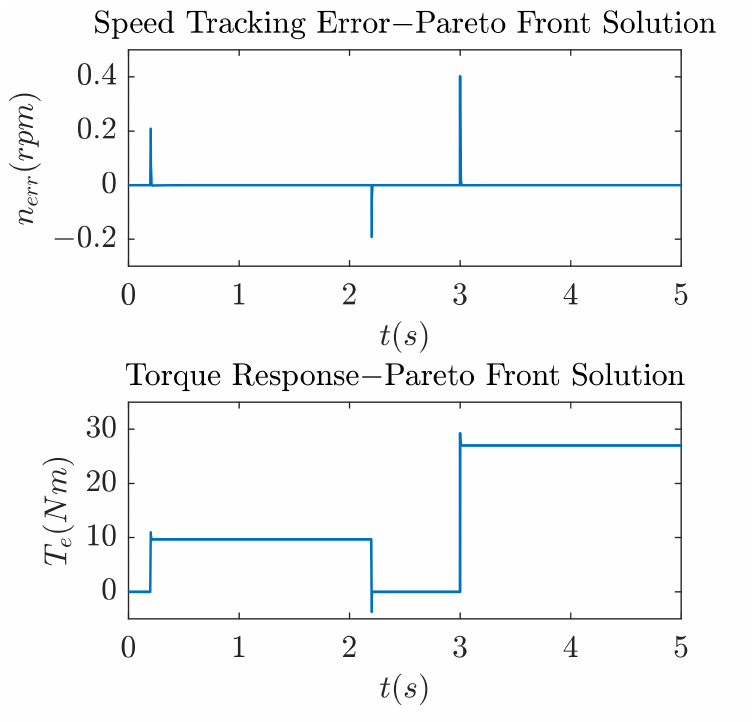
Figure 9. System response using the solution of the Pareto front. Figure 10 represents the speed and torque responses of the criteria from Equation (26) with the weighing factor of value 10. It can be seen that the torque overshoot is greatly reduced, while preserving a good speed tracking